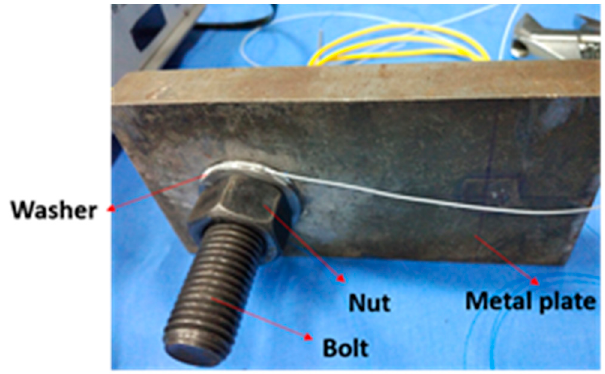
Figure 6. Calibration test of the FBG smart washer.